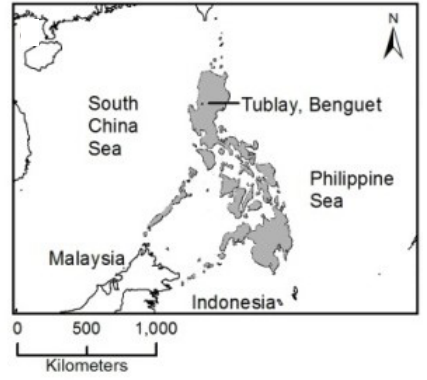
Figure 1. Location map of Tublay municipality, Benguet province in northern region of the Philippines (shaded